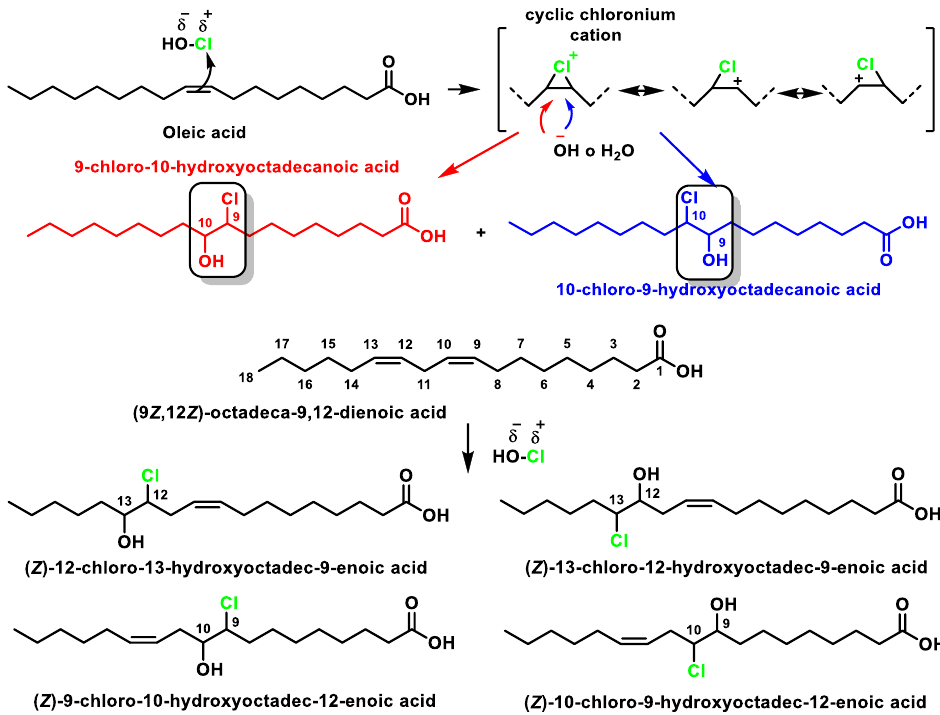
Figure 7. Electrophilic addition of HOCl to unsaturated fatty